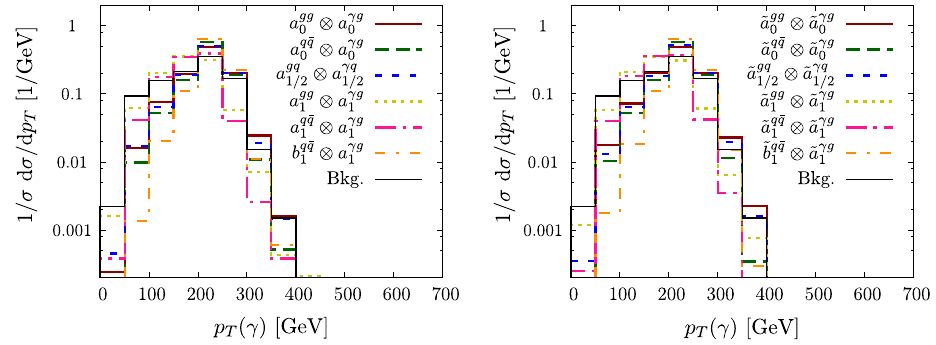
Fig. 2 Normalised transverse momentum distribution for jet+ γ pro- duction, focussing on the different spin j (here specifically j ≤ 1) and types of coupling detailed in Sect. 2. The lower index denotes the spin